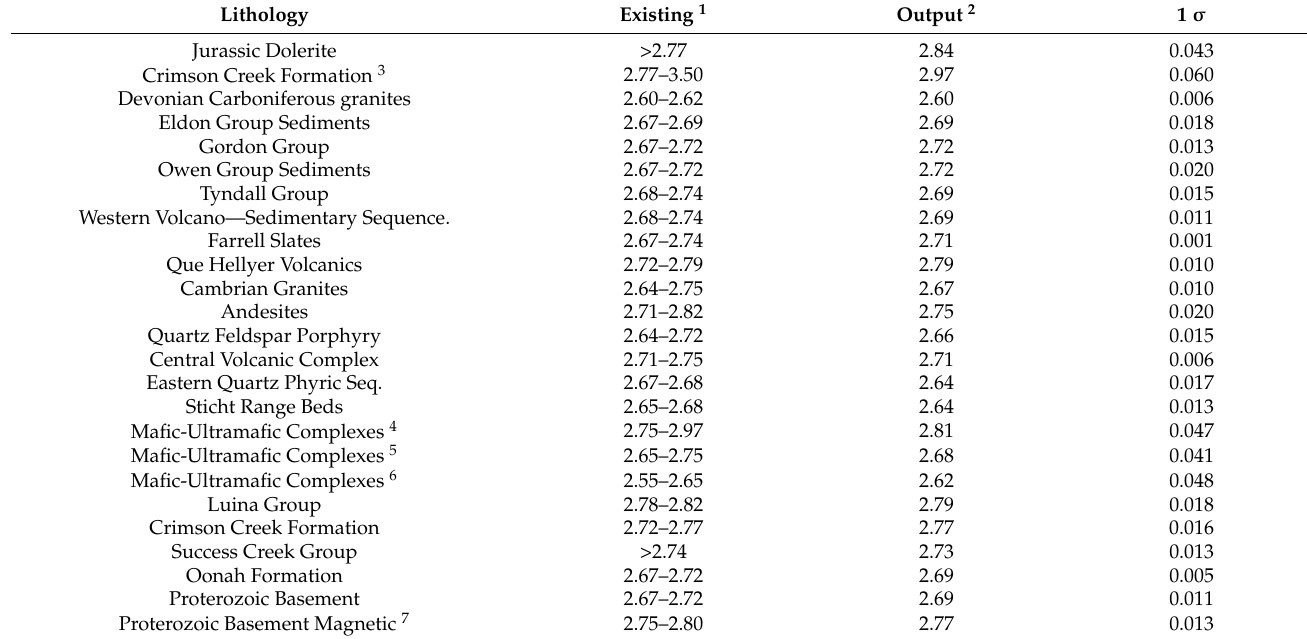
Table 1. Western Terrane existing and model-informed mean density (kg/m 3 ).